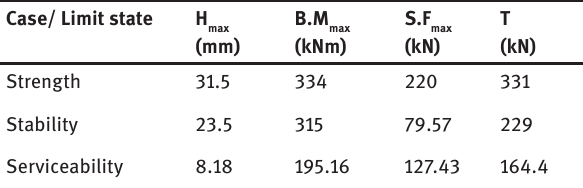
Table 7: Results of analysis with Indian codes.